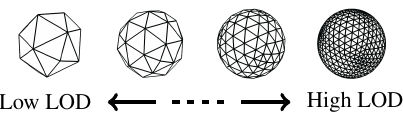
Figure 5. Levels of detail of a sphere in computer